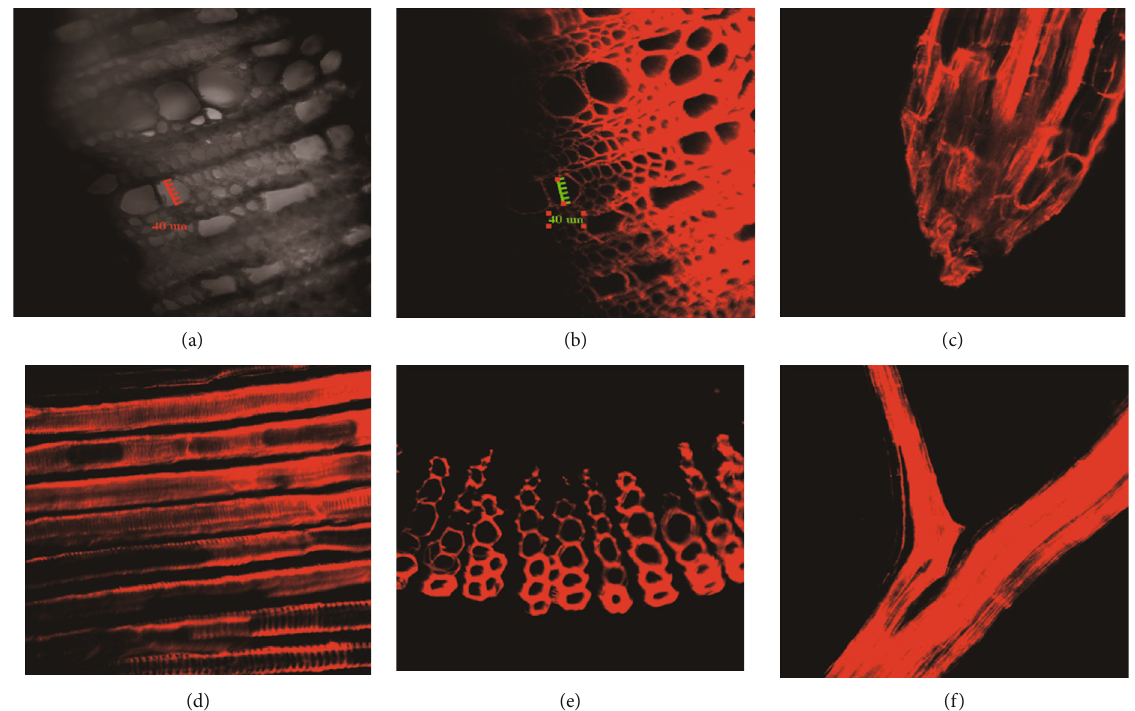
Figure 5: Fluorescence imaging of vanisulfane in tobacco plants ((a) the bright fi eld of the cross-section of the stem; (b) the fl uorescence fi eld of the cross-section of the stem; (c) the fl uorescence fi eld of the vertical section of the root; (d) the fl uorescence fi eld of the vertical section of the stem; (e) fl uorescence fi eld of leaf vein cross-section; (f) fl uorescence fi eld of leaf vein vertical